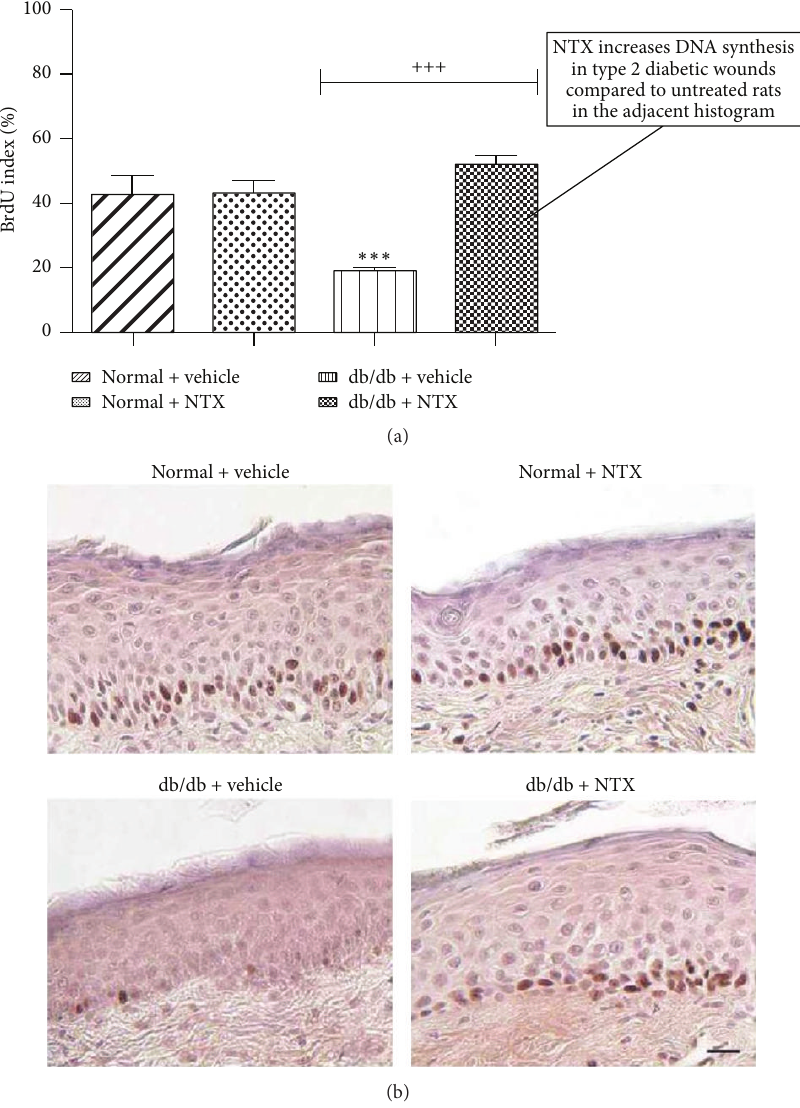
Figure 21: Spontaneously diabetic db/db mice with 5 mm full-thickness skin wounds on dorsum were treated with topical 10 −5 M NTX in moisturizing cream or saline dissolved in moisturizing cream TID × 14 days. (a) DNA labeling indices calculated from the number of BrdU-positive basal cells relative to the total number of basal cells. Depressed DNA synthesis is noted in the DB rats compared to normal or NTX-treated DB animals. NTX-treated DB mice had BrdU LI of 52% compared to 43% for normal and NTX-treated normal animals. Values represent mean ± SEM. Significantly different from normal + vehicle group at ∗∗∗ 𝑃 < 0.001 . Labeling indexes in NTX-treated diabetic (db/db + NTX) skin were significantly different from measurements in saline-treated tissue from T2D mice (db/db + vehicle) at +++ 𝑃 < 0.001 . (b) Sections of the skin treated as above illustrate the relative labeling amounts of the treatment groups (derived from